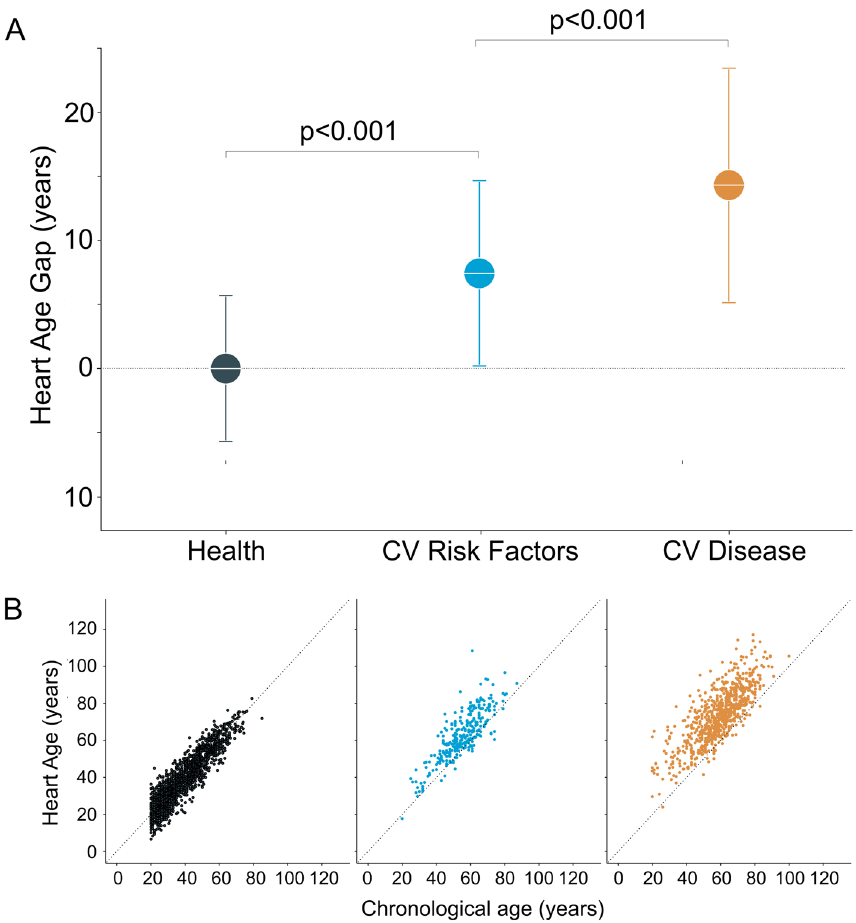
Figure 2. ( A ) The difference (the Heart Age Gap) between the 10-s ECG Heart Age and chronological age in healthy subjects (left, dark green), subjects at cardiovascular (CV) risk (middle, light blue), and patients with CV disease (right, yellow). On average, there is no difference between Heart Age and chronological age in healthy subjects. Heart Age Gap is higher in subjects at CV risk, and highest for those with overt CV disease. ( B ) Scatter plots showing the relationship between the 10-s ECG Heart Age and chronological age in healthy subjects (left, dark green), subjects at CV risk (middle, light blue), and patients with CV disease (right, yellow). The dashed diagonal line is the identity line, i.e. indicating no difference between Heart Age and chronological